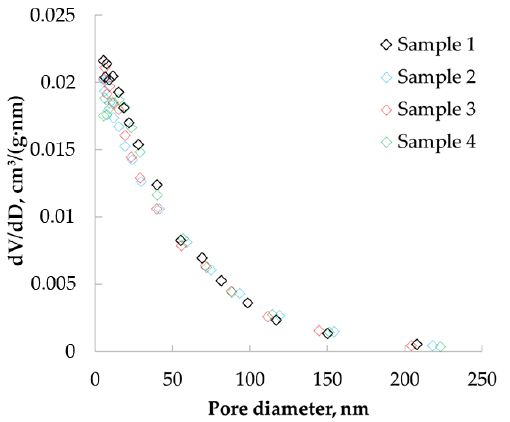
Figure 6. Pore size distribution for chitosan-based aerogel samples particles (in the range of 0–250 nm).